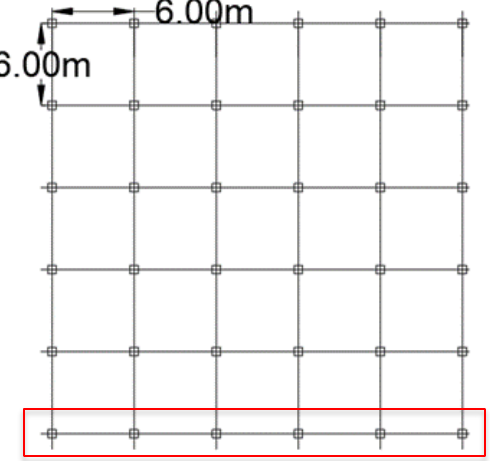
Figure 1. Plan view of the RC building.